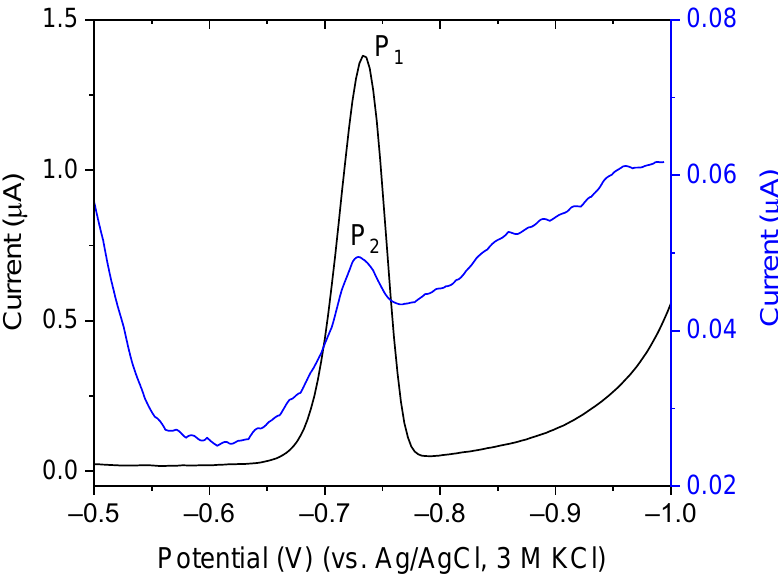
Figure 11. DP AdSV voltammograms recorded for: (1) 0.05 M acetate buffer containing 1 mM of pyrogallol and 15 nM of Ge(IV), (2)—as for (1) but with the addition of 1 mM of V(IV) and 2 mM of HEDTA. E acc = − 0.1 V, t acc = 60 s Reprinted with permission from ref. [42]. Copyright 2020 John Wiley and Sons.